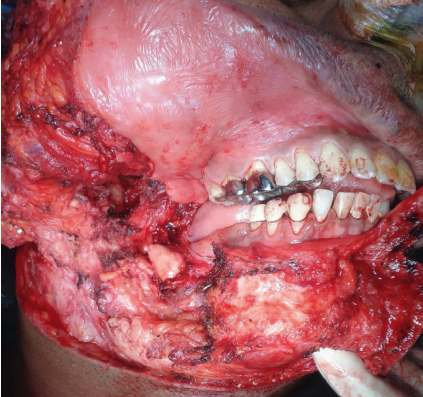
Figure 2: Surgical photograph shows the exposure of the lesion.